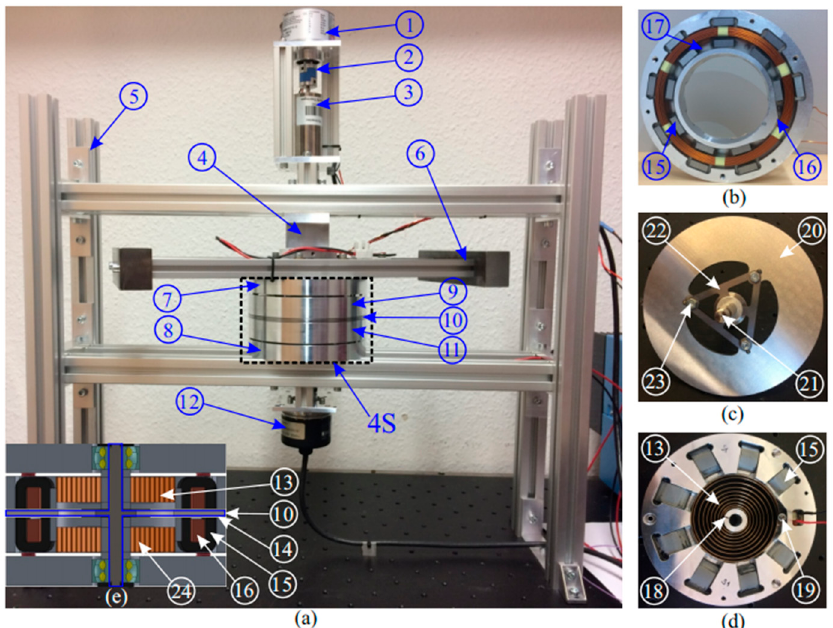
Figure 3. ( a ) Photograph of the experimental 4S; ( b ) electromagnet plate, view from air-gap side; ( c ) armature shaft; ( d ) electromagnet plate 1 with spring 1, view from top. 1 — incremental encoder 1;